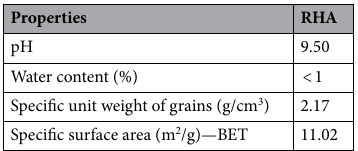
Table 1. Physico-chemical characterization of RHA.